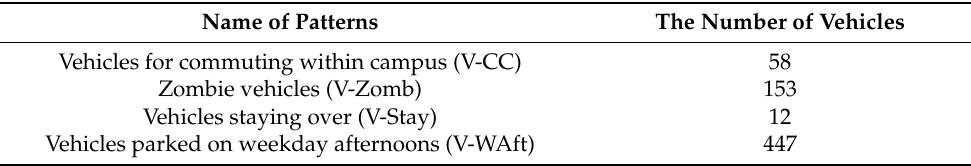
Table 3. The number of vehicles in each of the interesting patterns.